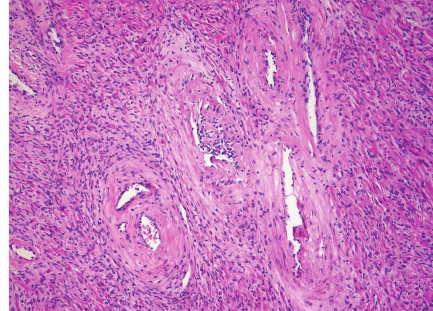
Figure 2: Detail of the blood vessels with hyalinized wall.